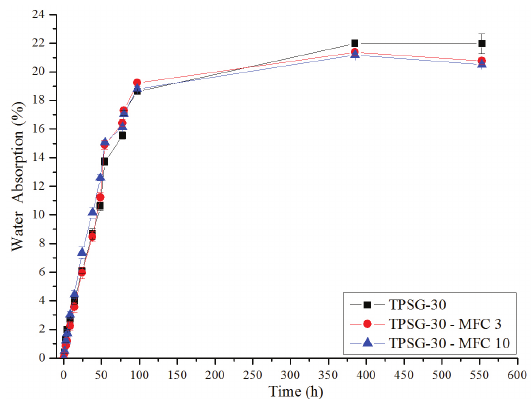
Figure 5. Water absorption curves as a function of conditioning time for different materials in an environment of relative humidity of (a) 43, (b) and 53 (c)